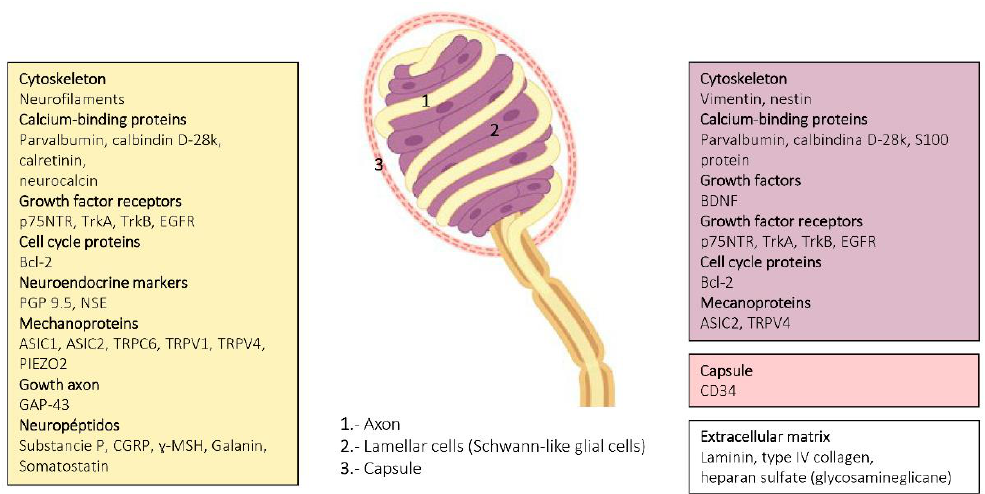
Figure 4. Schematic representation of Meissner corpuscles showing the proteins detected in the different corpuscular components using immunohistochemistry. Axon : yellow box, lamellar cells : purple box, capsule : pink box.